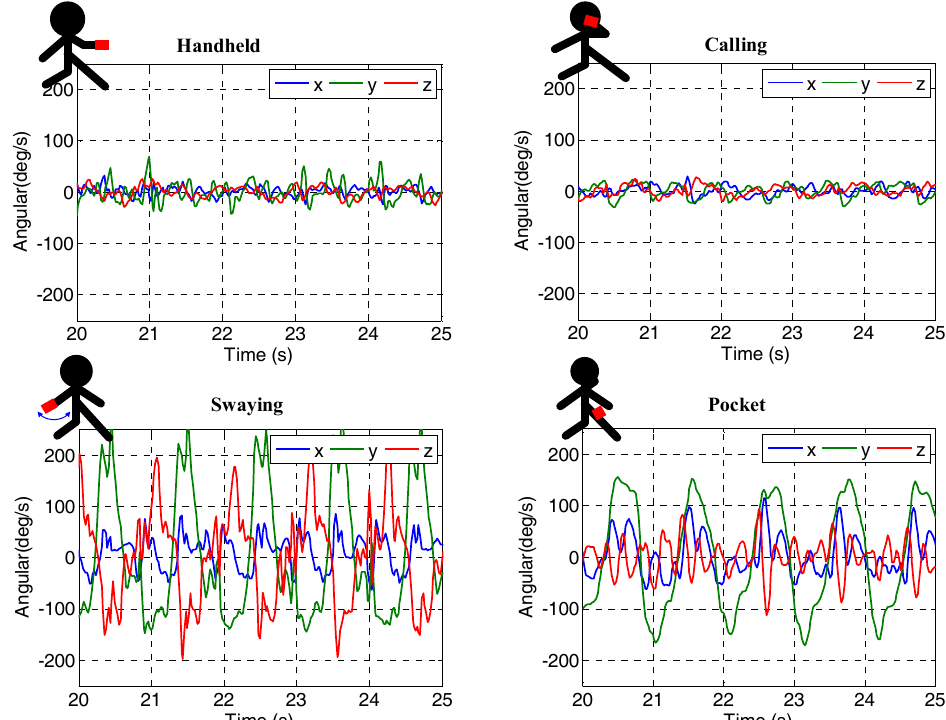
Figure 4. Four basic smartphone-holding positions and corresponding gyro readings.